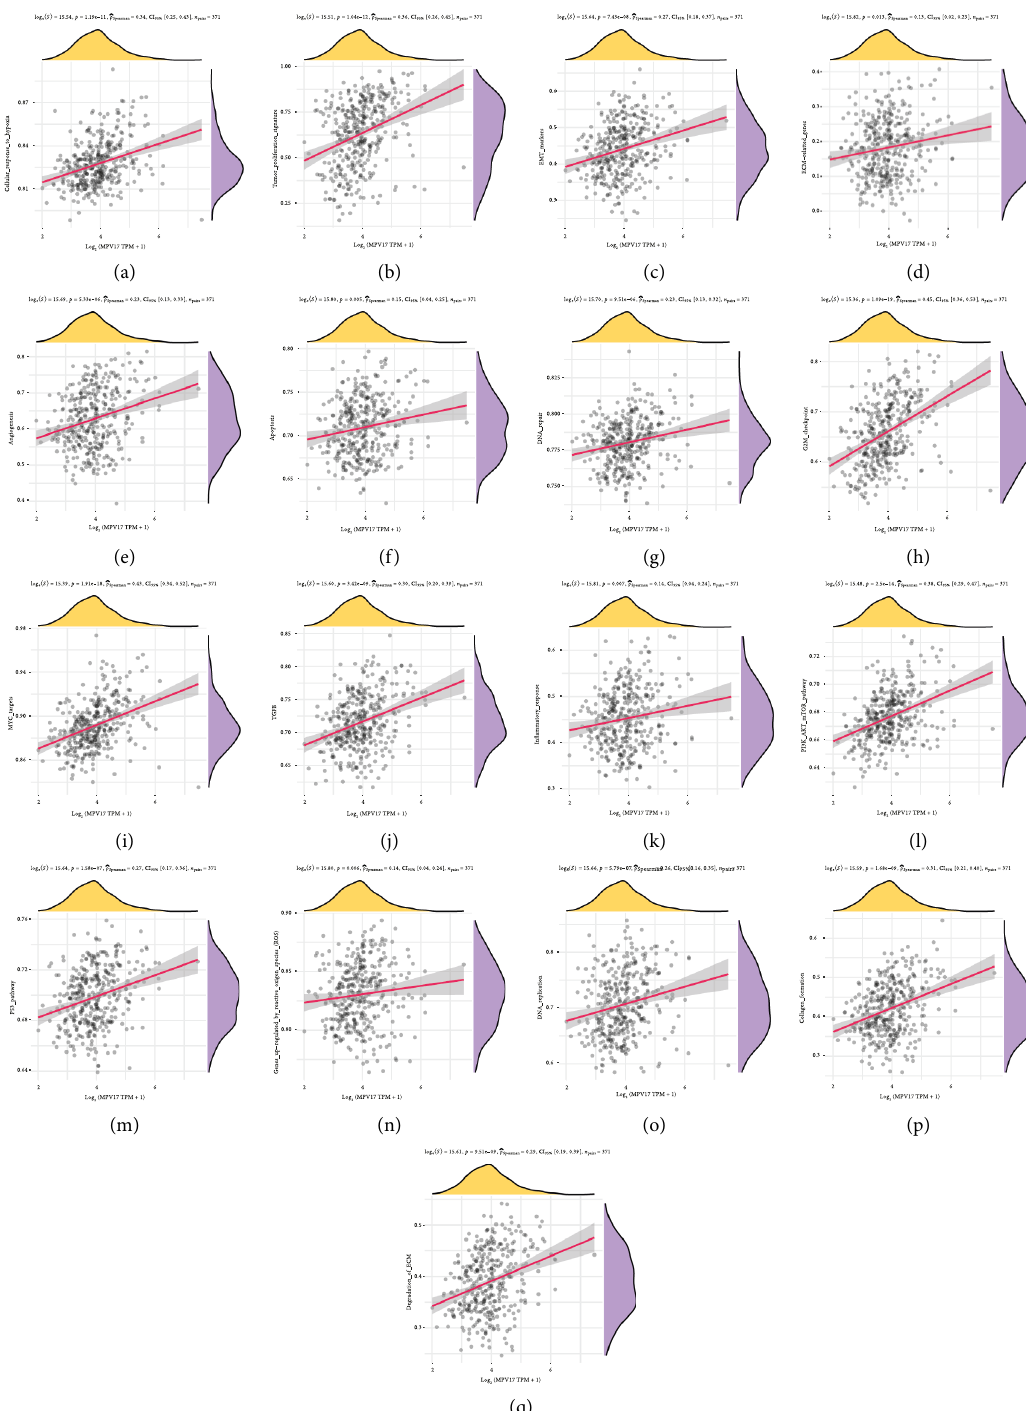
Figure 6: Pathway correlation analysis on MPV17. (a–q) Spearman’s correlation analysis between MPV17 and 17 pathways’